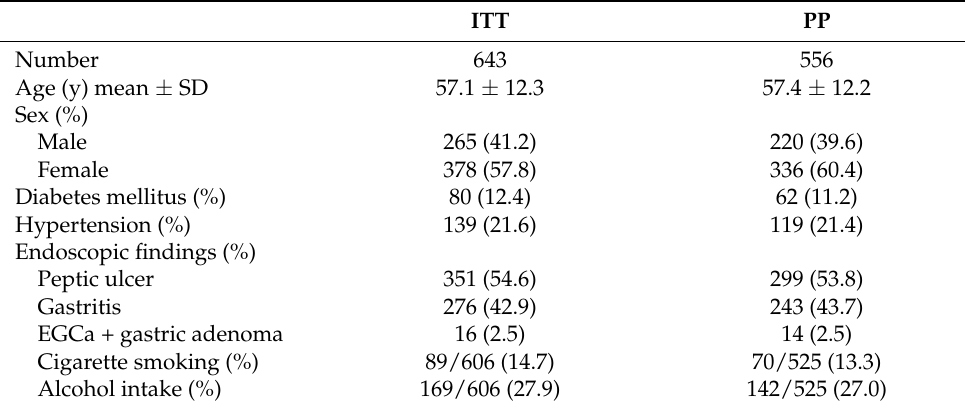
Table 2. Cumulative eradication rates per year-periods.